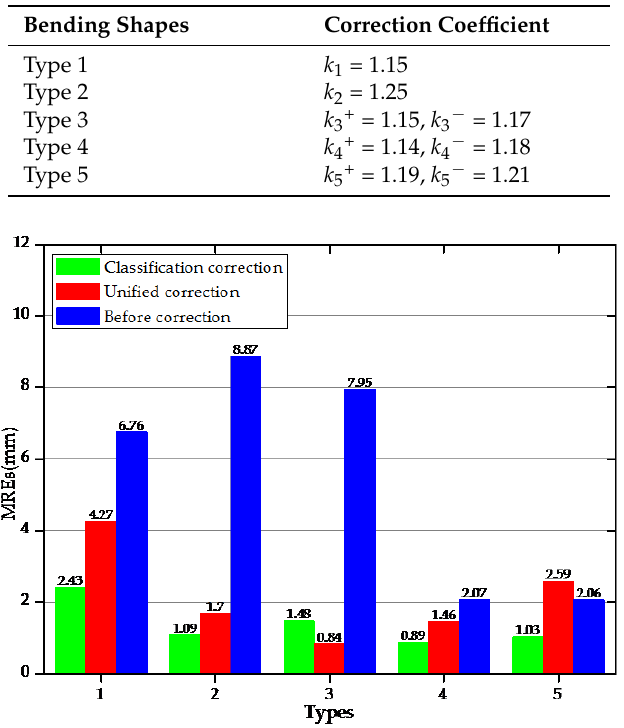
Table 5. Correction coefficients of each bending morphology.